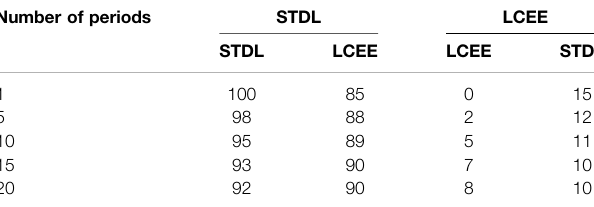
TABLE 6 | Variance decomposition results based on the PVAR model estimation. Number of